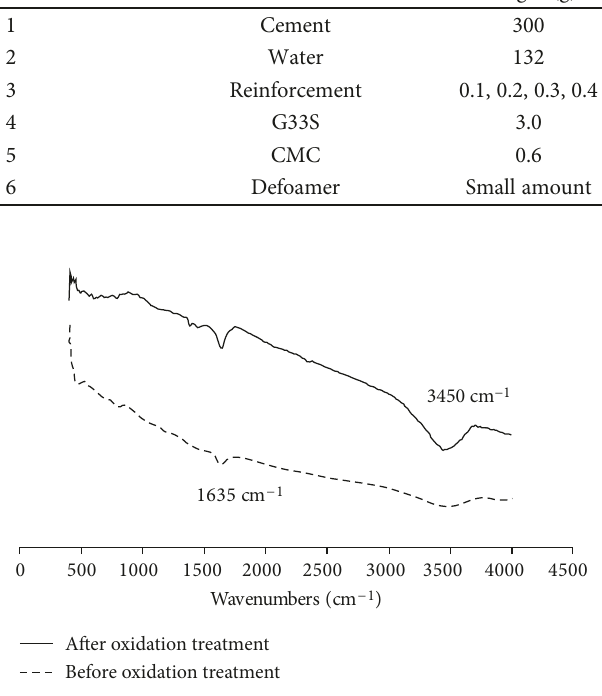
Figure 2: Infrared spectrum of carbon fi bers before and after oxidation